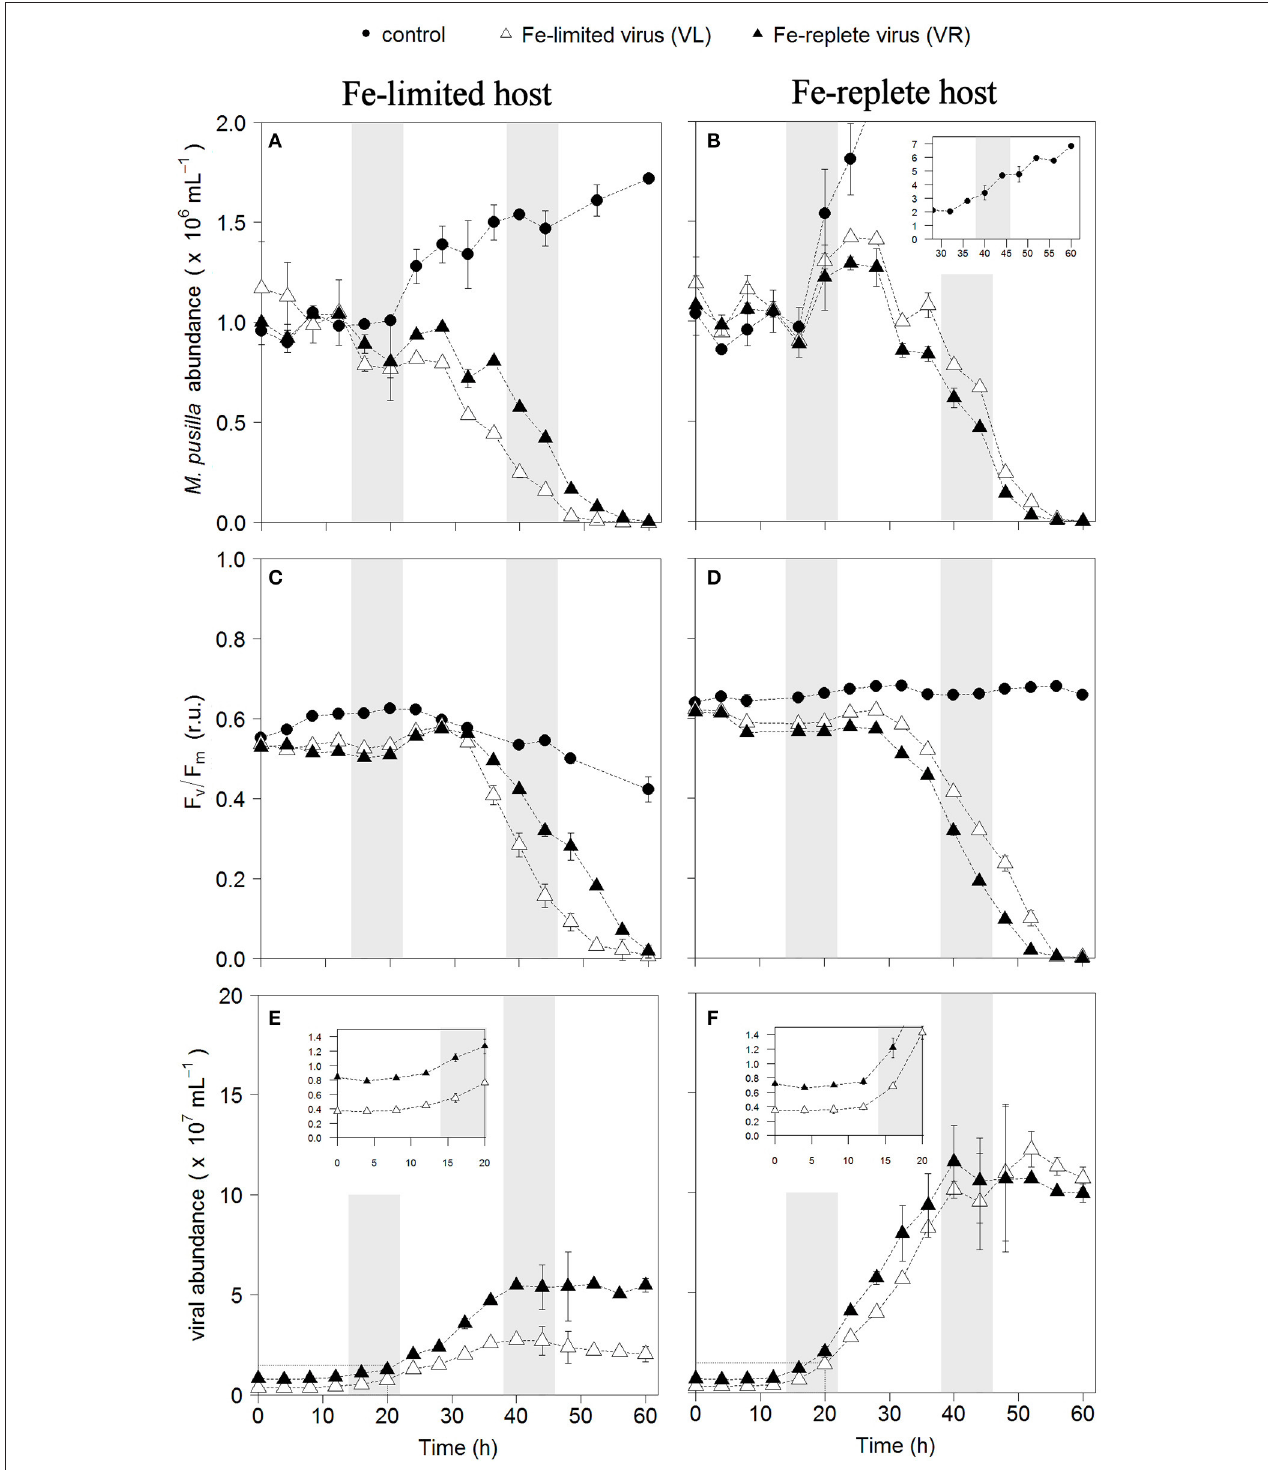
FIGURE 2 | Temporal dynamics of M. pusilla viral infections: host cell abundance over time (h) in Fe-limited (A) and Fe-replete cultures (B); photosynthetic capacity (F v /F m ) over time (h) of Fe-limited (C) and Fe-replete cultures (D); viral abundance in Fe-limited (E) and Fe-replete (F) cultures. Circles represent non-infected controls, black triangles represent infections with Fe-replete host derived viruses (VR) and white triangles represent infections with